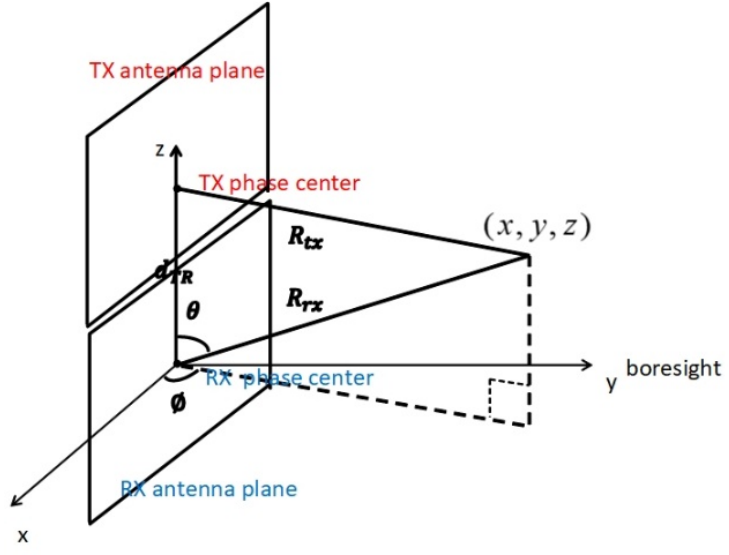
Figure 2. The TX and RX antenna array panels and the target ( R rx and R tx are much bigger than d TR in the real system).